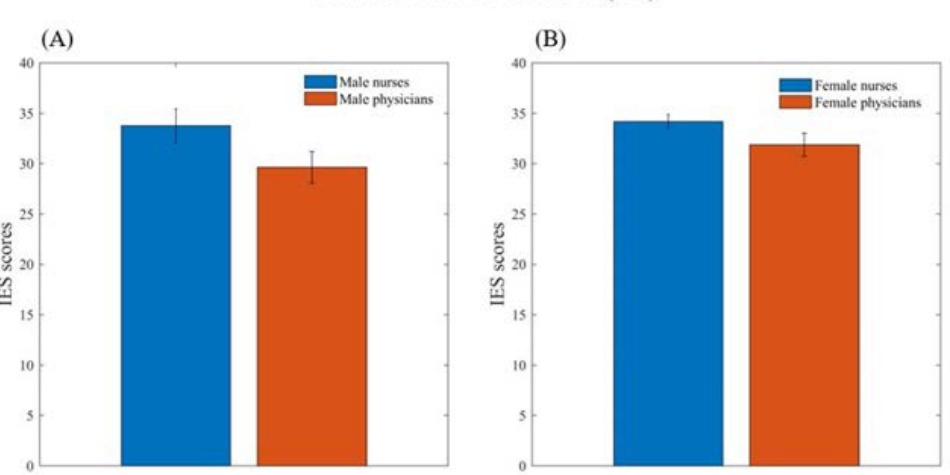
Figure 1. Mean (and SE) of Impact of Event Scale (IES) total score in male nurses (n = 45) and physicians (n = 28) and ( A ) Mean (and SE) of Impact of Event Scale (IES) total score in female nurses (n = 167) and physicians (n = 47) ( B ).